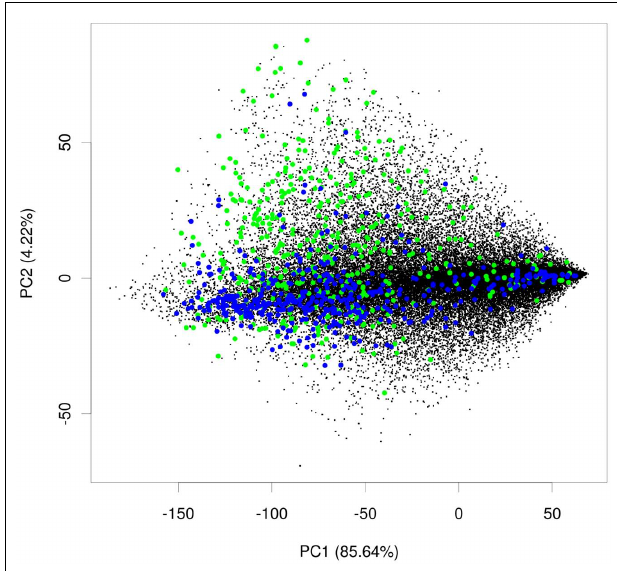
FIGUREA2 | PCA plot for rice. Principal component analysis plot showing plastid proteins in green, mitochondrial proteins in blue, and proteins from other compartments in